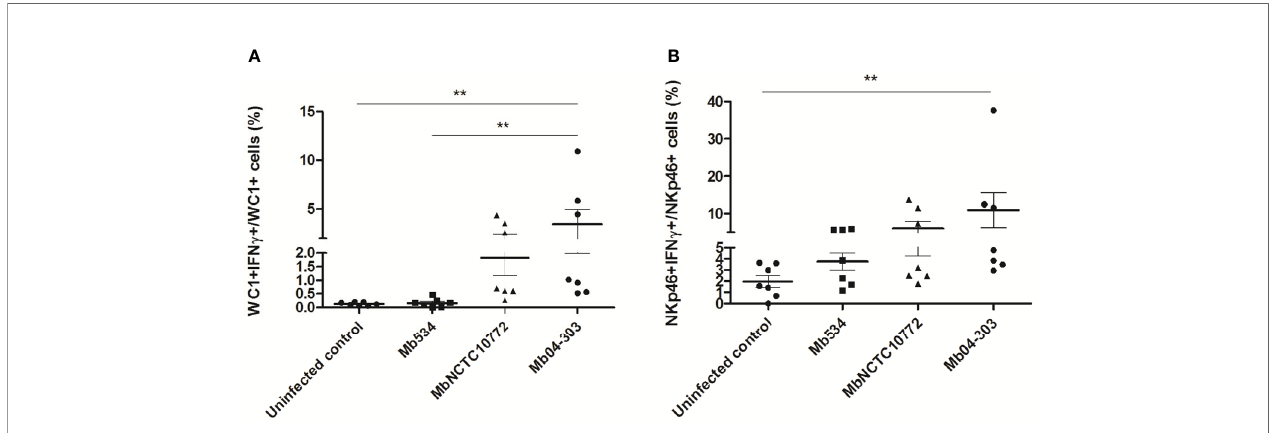
FIGURE 4 | IFN- g intracytoplasmic quanti fi cation assessed by fl ow cytometry in infected co-cultures (MOI=1) of cells obtained from seven different calves (N=7). For each animal sample and condition tested, a single cell well was analyzed. The results are expressed as IFN- g + cells in total WC1+ (A) and NKp46+ (B) populations. Each symbol represents an individual animal; horizontal lines represent mean values and whiskers SEM. **p < 0.01 determined by Friedman test with Dunn ’ s post-test for multiple comparisons.